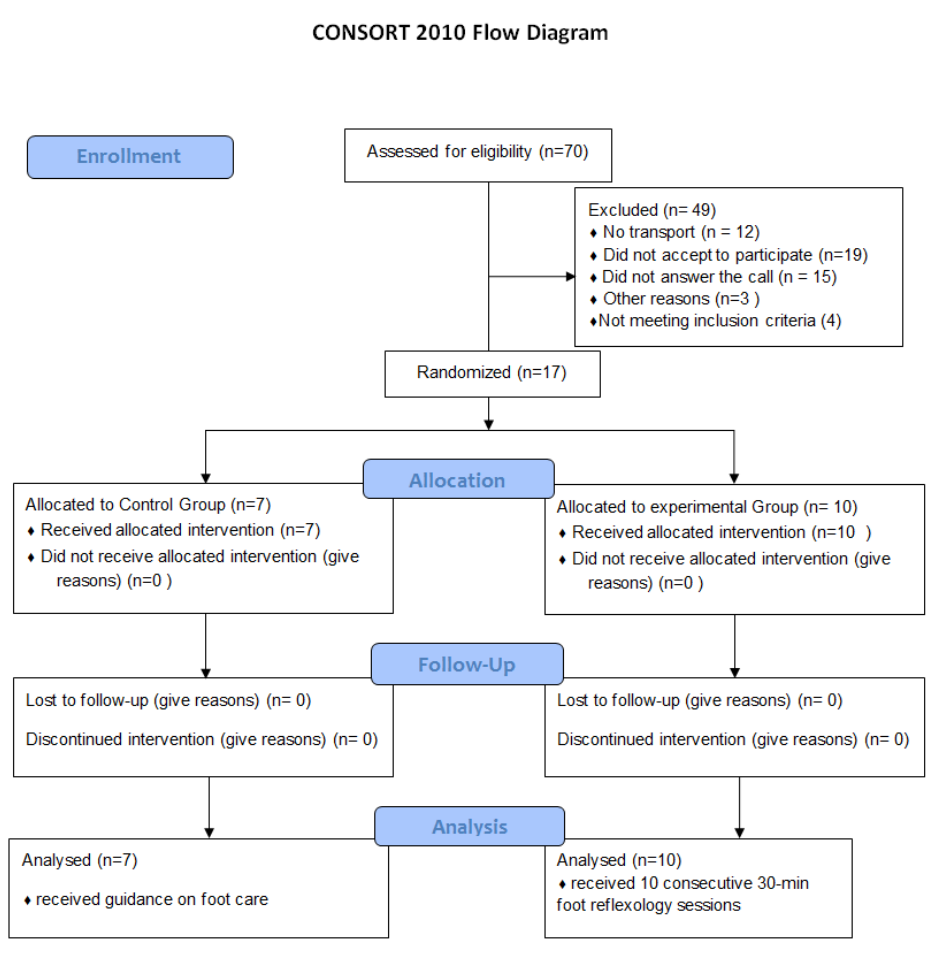
Figure 1. Flow diagram based on CONSORT 2010.